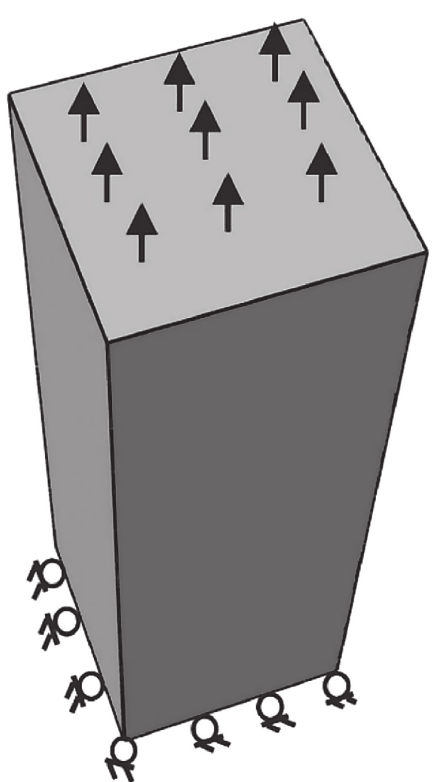
Figure 2: Specimen loading and boundary condition.